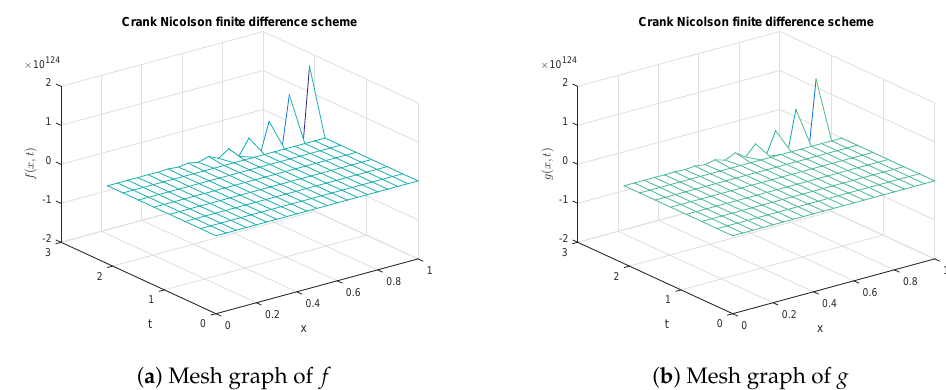
Figure 2. Graphical solution of f , g (concentration of substances) using Crank Nicolson method at a = 3.5, b = 0.25, χ 1 = 6, χ 2 = χ ∗